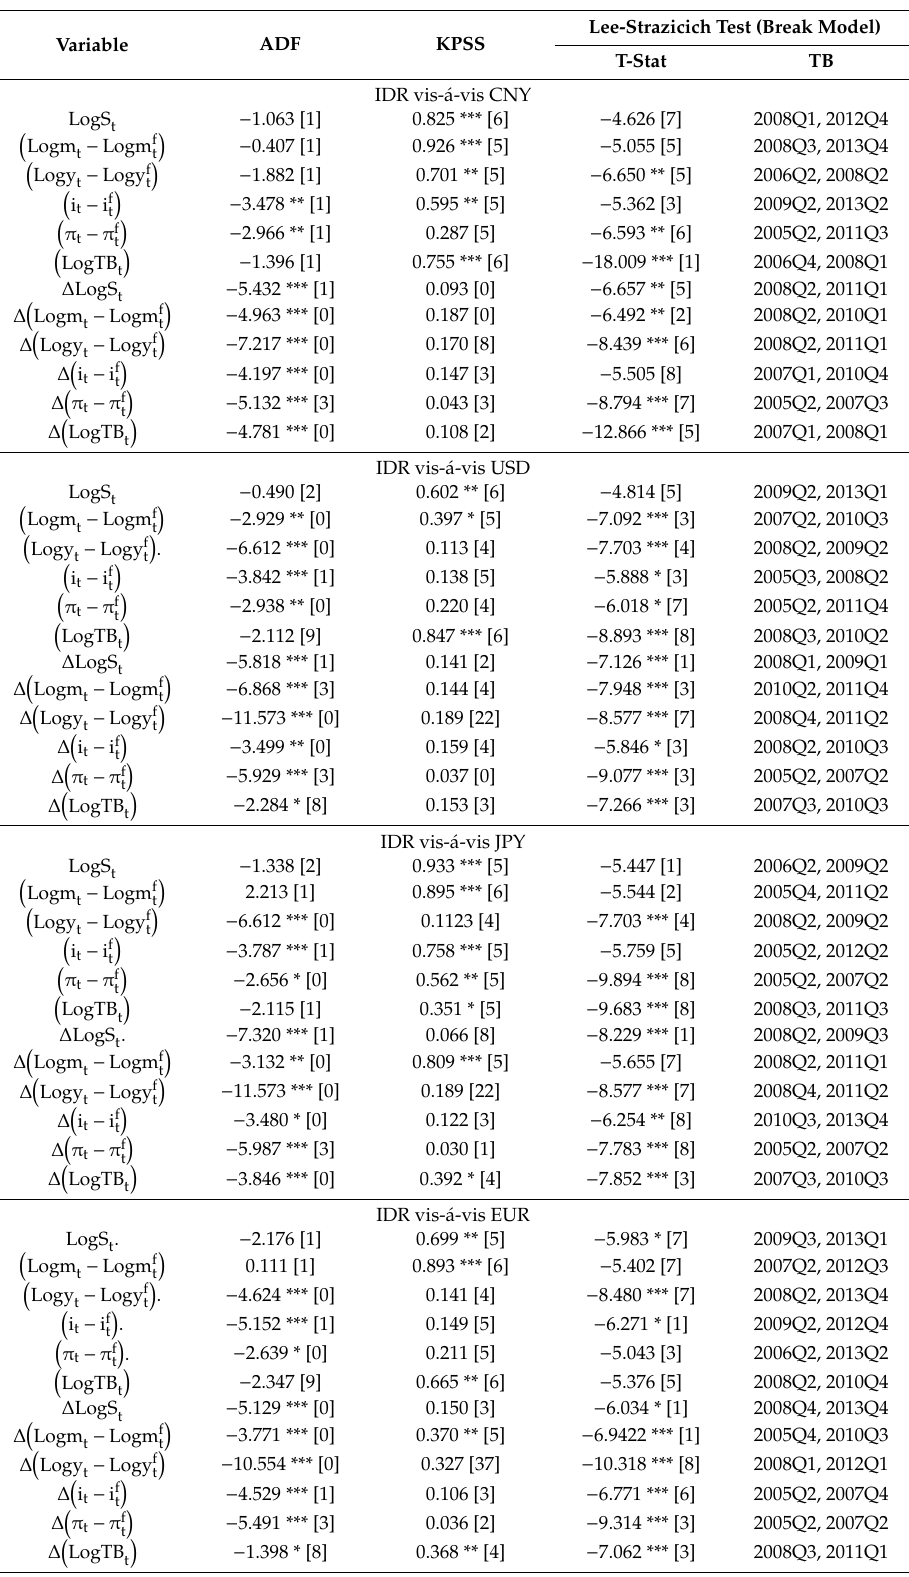
Table 1. Unit Root Testing